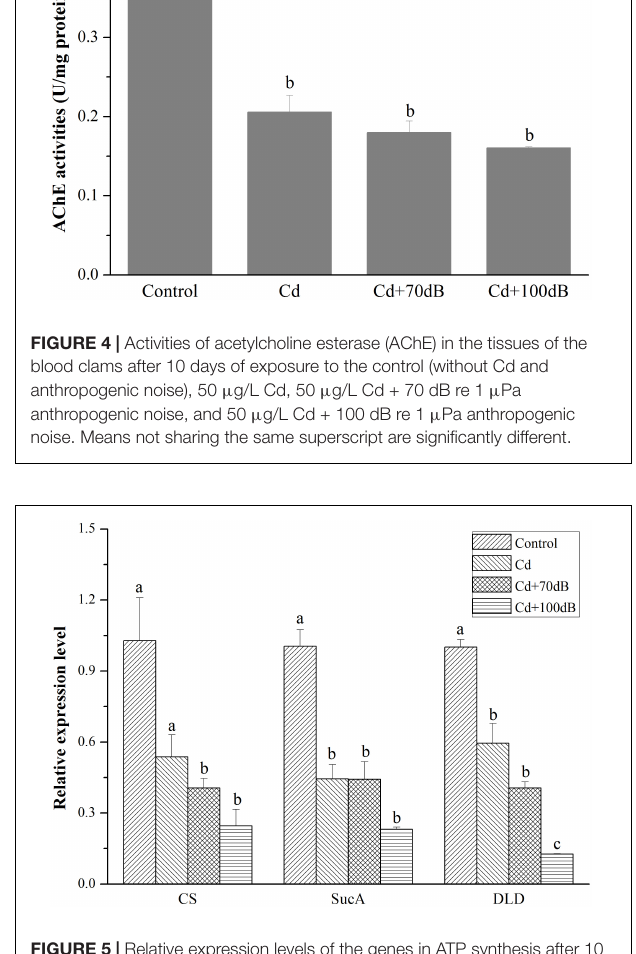
FIGURE 5 | Relative expression levels of the genes in ATP synthesis after 10 days exposure to the control (without Cd and anthropogenic noise), 50 µ g/L Cd, 50 µ g/L Cd + 70 dB re 1 µ Pa anthropogenic noise, and 50 µ g/L Cd + 100 dB re 1 µ Pa anthropogenic noise. Means not sharing the same superscript are significantly